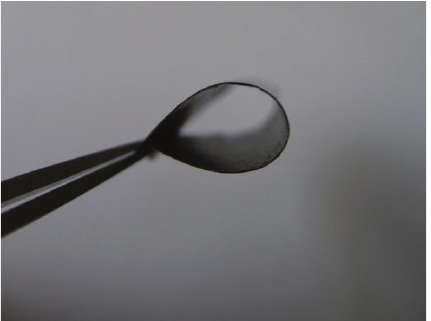
Figure 1: Photograph of a flexible film of the PPy/T-CNs nanocom- posite.